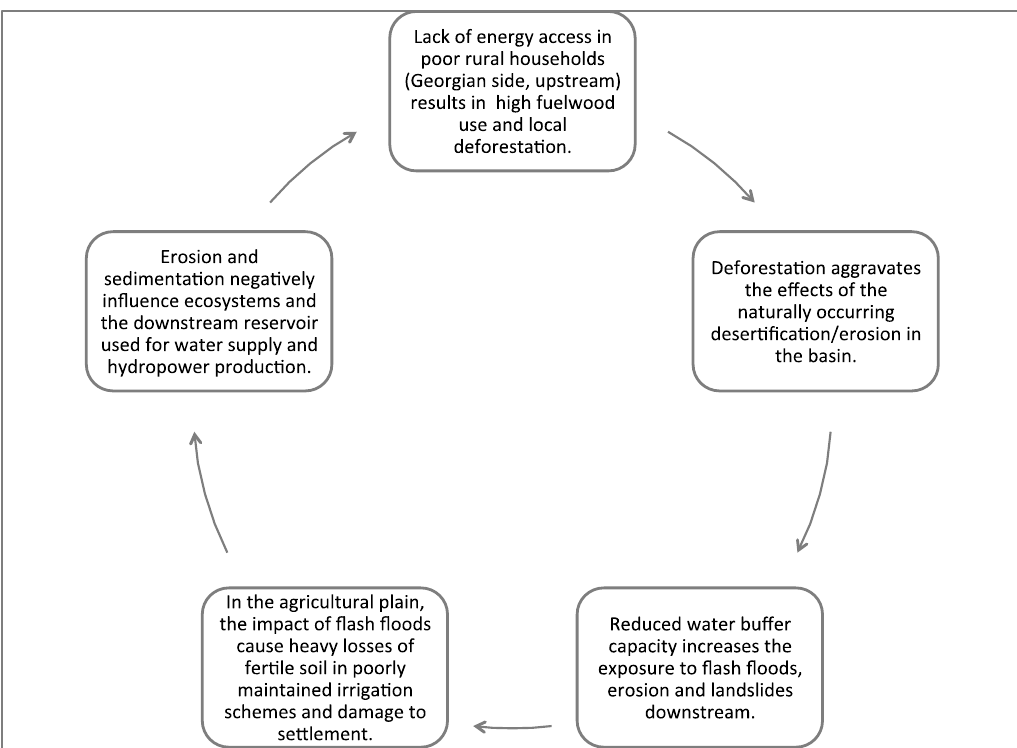
Figure A4. Nexus storyline for the Alazani/Ganykh River Basin.